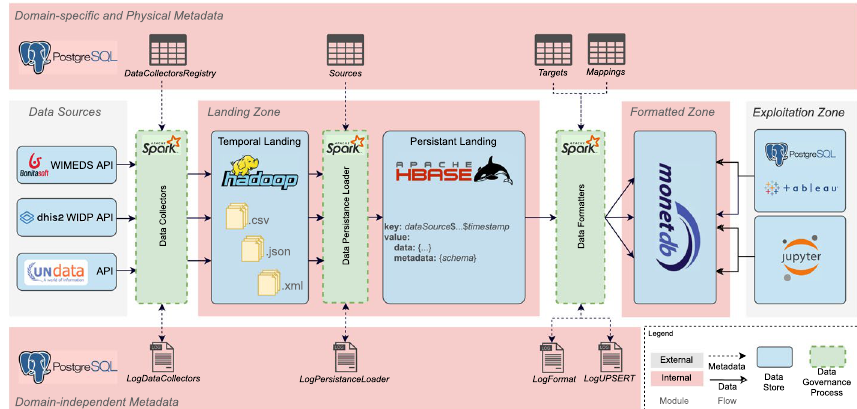
Fig. 10 Instantiation of the system architecture for WISCENTD use